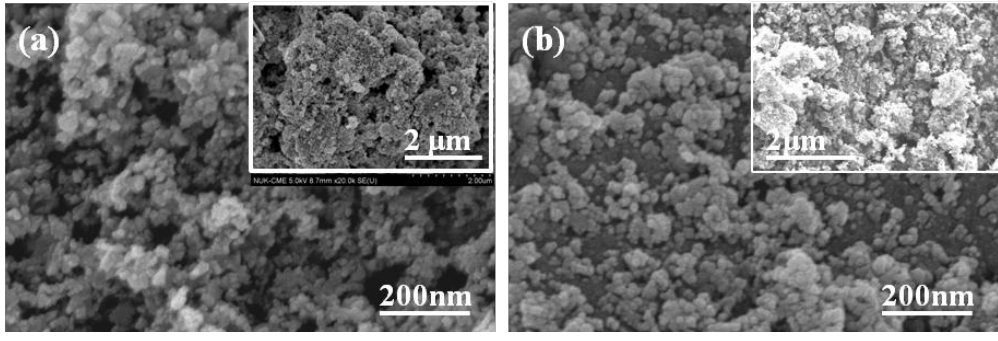
Figure 2. Micrographs of ( a ) the synthesized CIS powder; ( b ) grinding and baking CIS power.